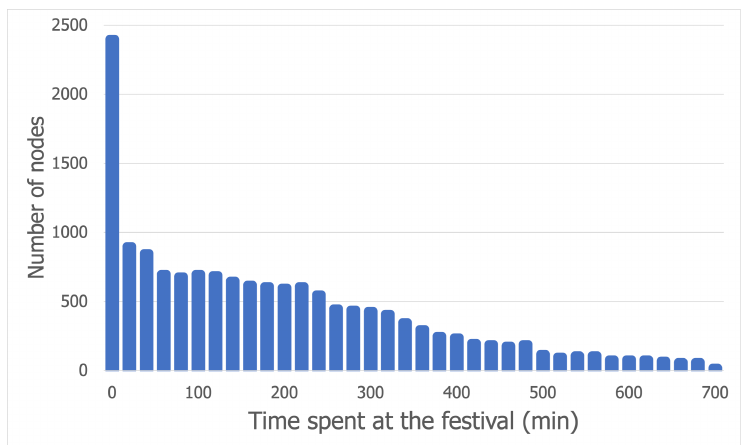
Figure 1. Outlier values for day 1 of the Sonar